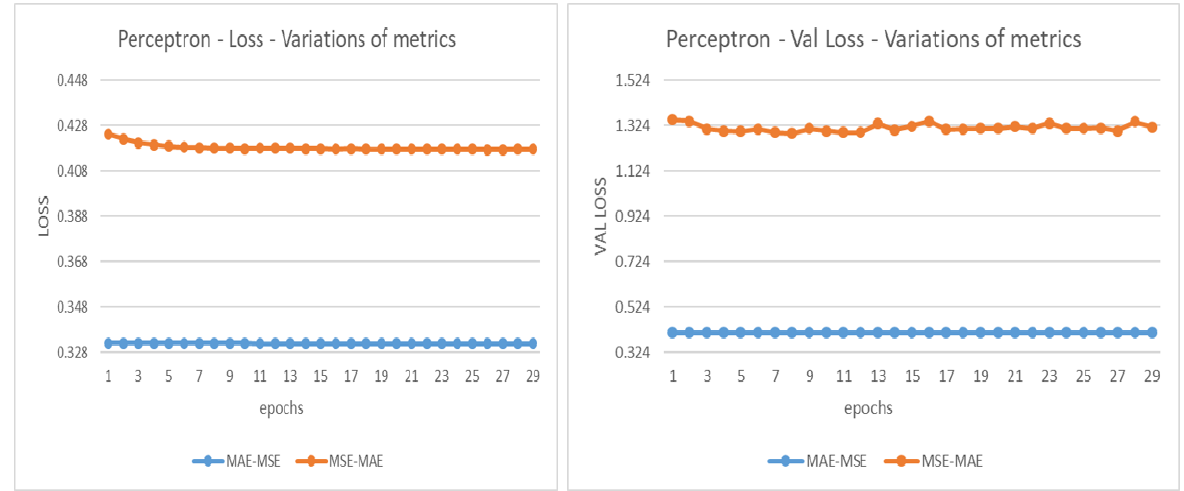
Figure 10. Source: Comparative results of tests on neuron variation. Own elaboration.